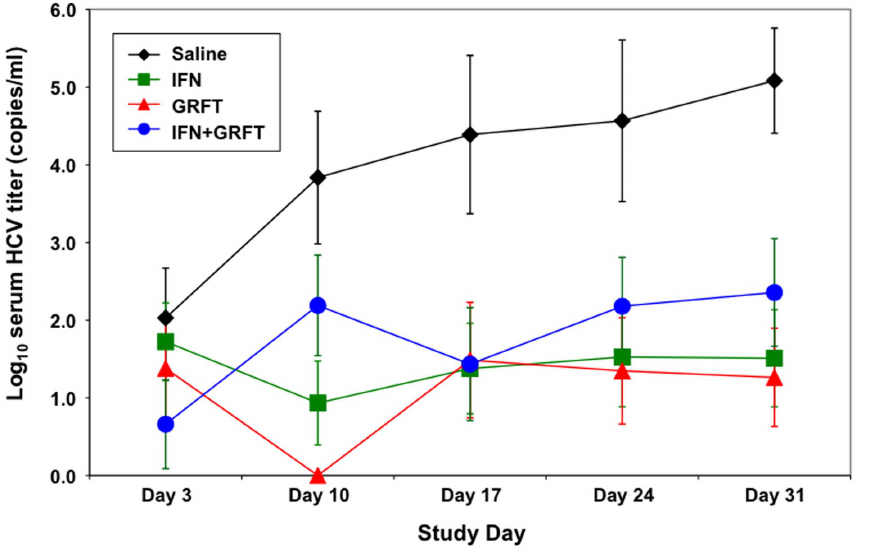
Figure 8. GRFT invivo activity at reducing viral titers prior to challenge with HCV. Serum HCV titer changes for griffithsin treated (blue, n=6), IFN- a treated (red, n=6), GRFT + IFN a -treated (green, n=7) and saline control treated (black, n=6) Alb-uPA/SCID transgenic mice engrafted with human hepatocytes during an 18-day treatment regimen. On Day 31 the differences in mean log titers between the saline control and both single agent treatment groups were statistically significant: saline vs Interferon p=0.010; saline vs Griffithsin p=0.020. The difference in mean log titer between the saline and combination groups was not significant (p=0.053). Error bars show the standard error for values at each time point. The minimum detectable limit of the virus load assay is 200